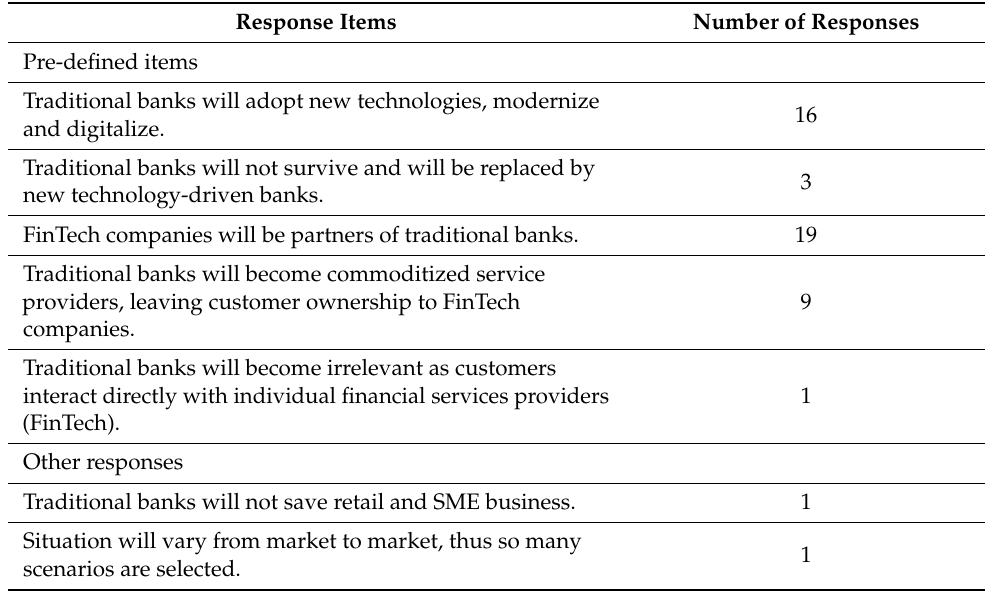
Table 1. Responses to the question how the FinTech companies will change traditional banks (multiple responses